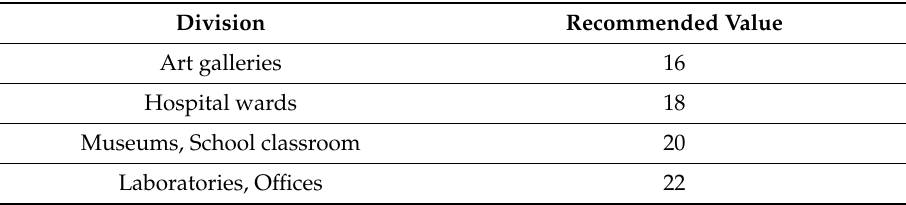
Table 13. Hopkinson’s recommended values for the Daylight Glare Index (DGI) by use [48].